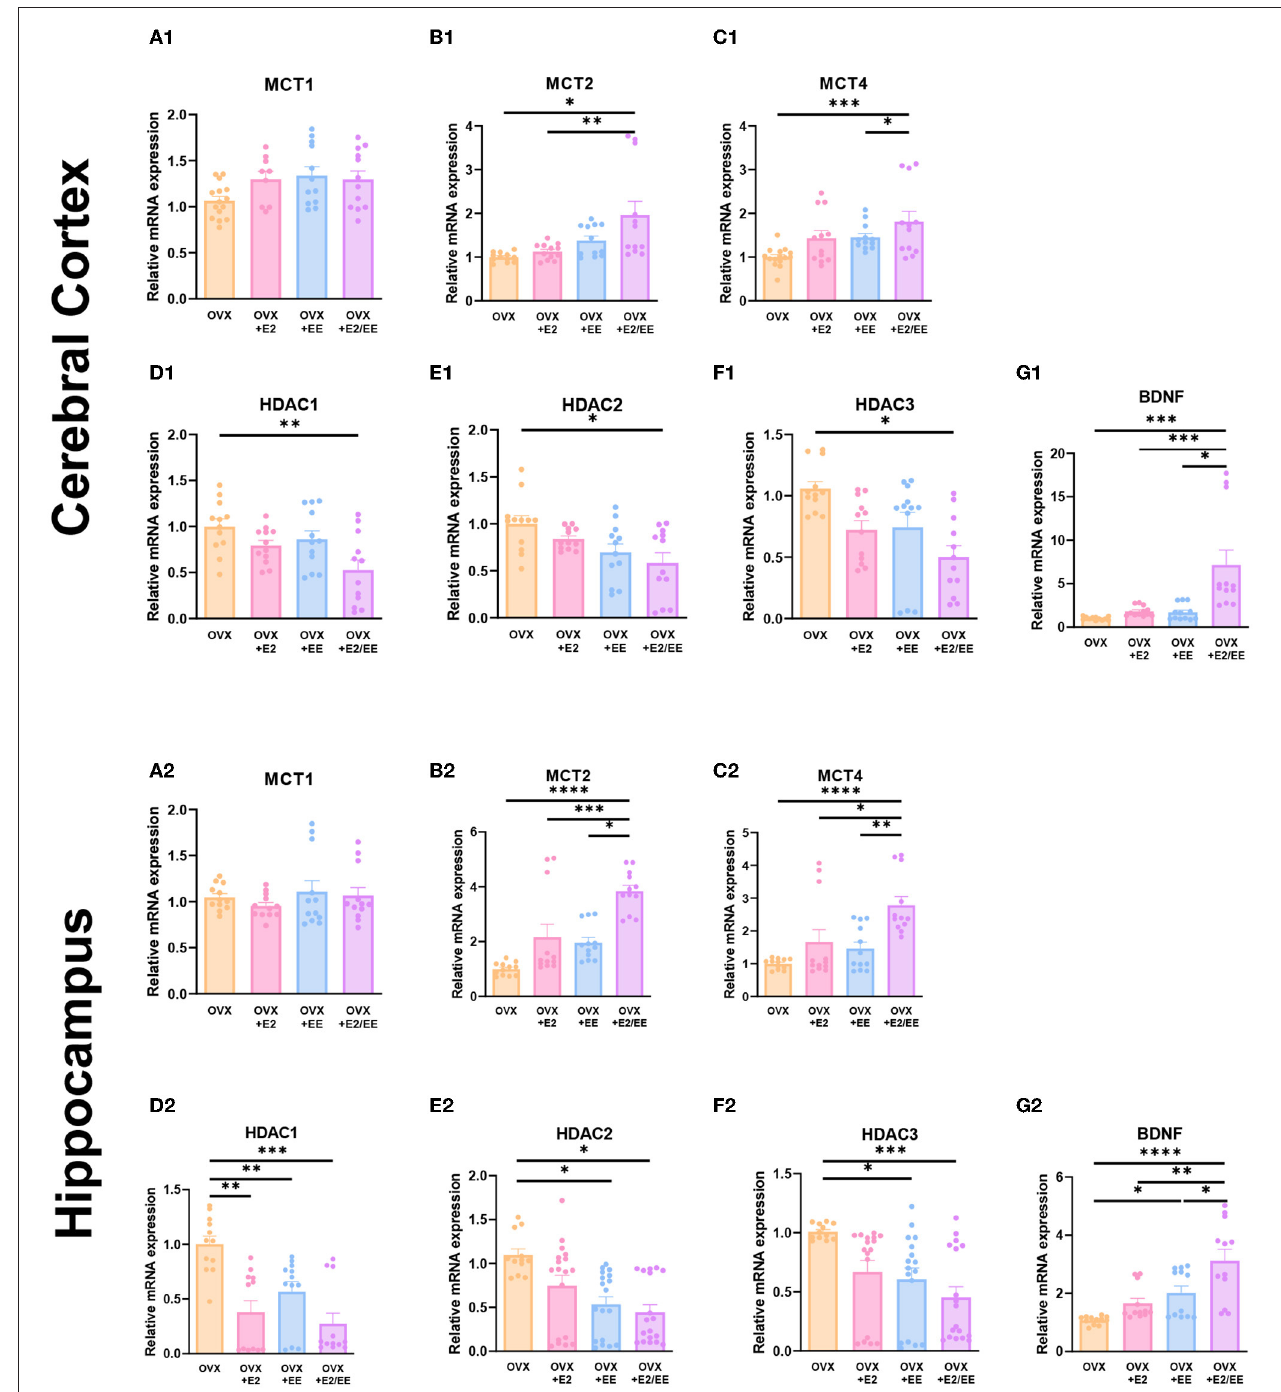
FIGURE 10 | Synergistic effects of estrogen and EE on the expression of ketone-related genes by qRT-PCR. (A1–G1) Cerebral cortex and (A2–G2) hippocampus mRNA levels for β HB-related genes measured using qRT-PCR ( n = 4 per group). All samples were run in triplicate. One-way ANOVA with Tukey multiple comparison test. Data represented are means ± SEM. * p < 0.05, ** p < 0.01, *** p < 0.001, and **** p < 0.0001.